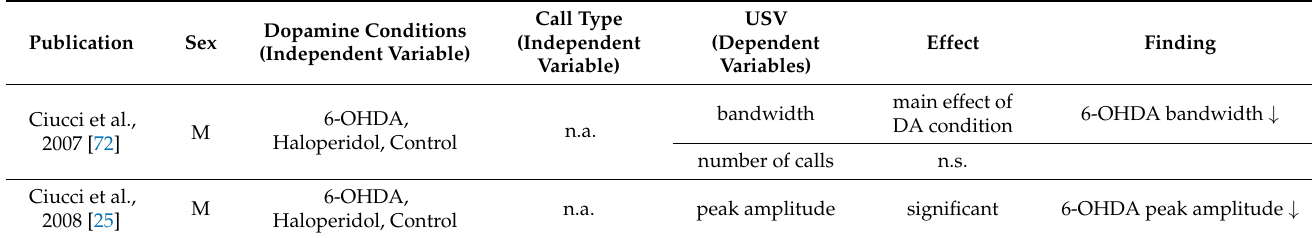
Table 1. Summary of main effects of dopamine condition and call type on USV